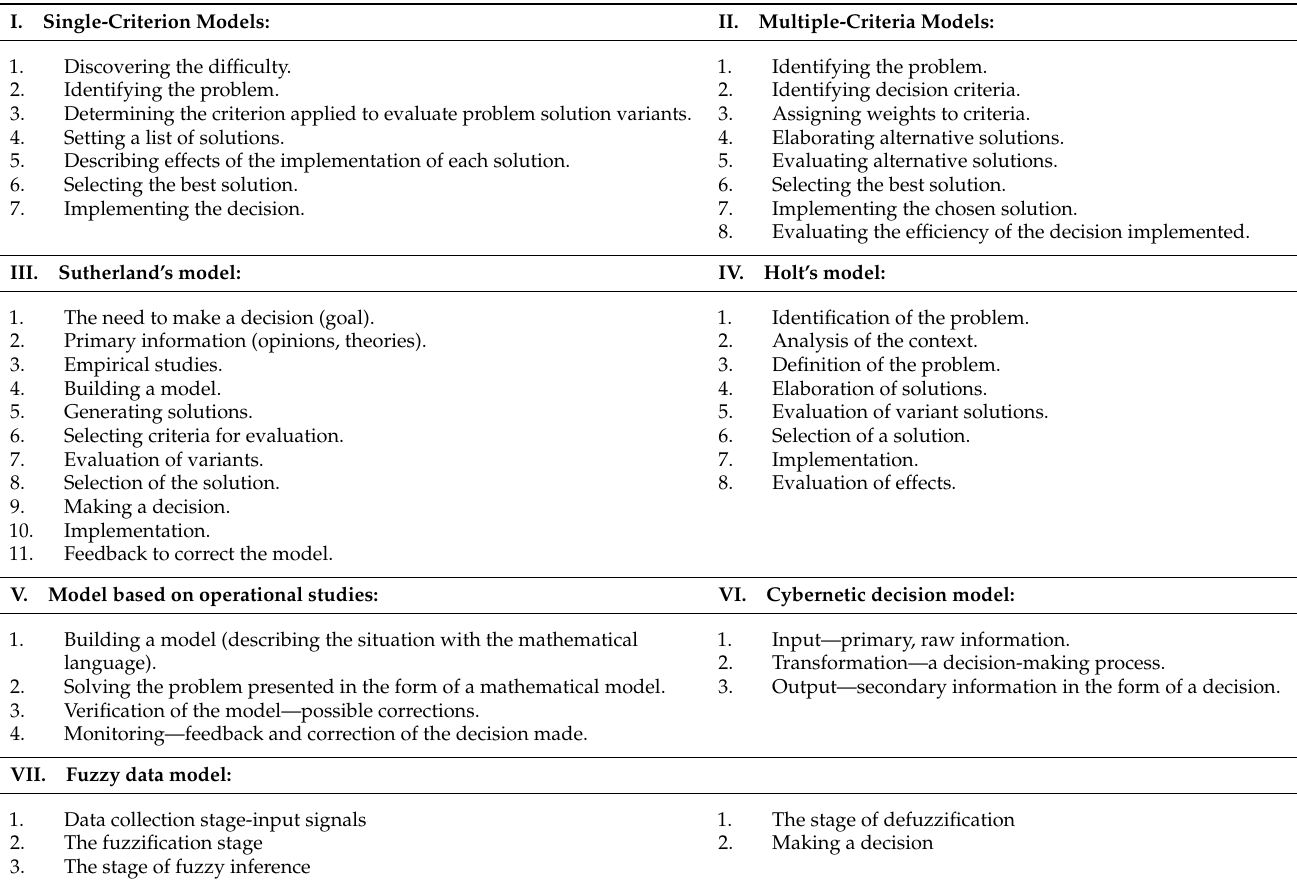
Table 2. Models of decision-making